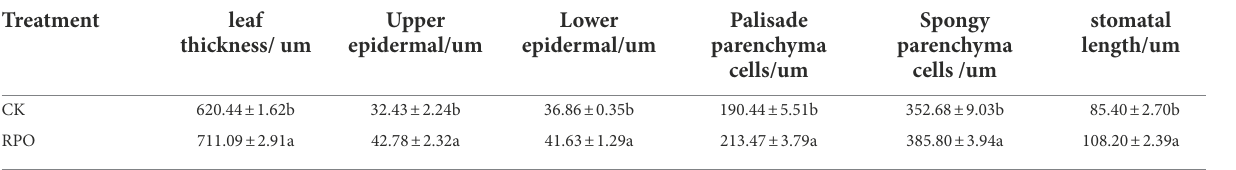
TABLE 2 Effect of RPO film on the structure of mature sweet pepper leaves.